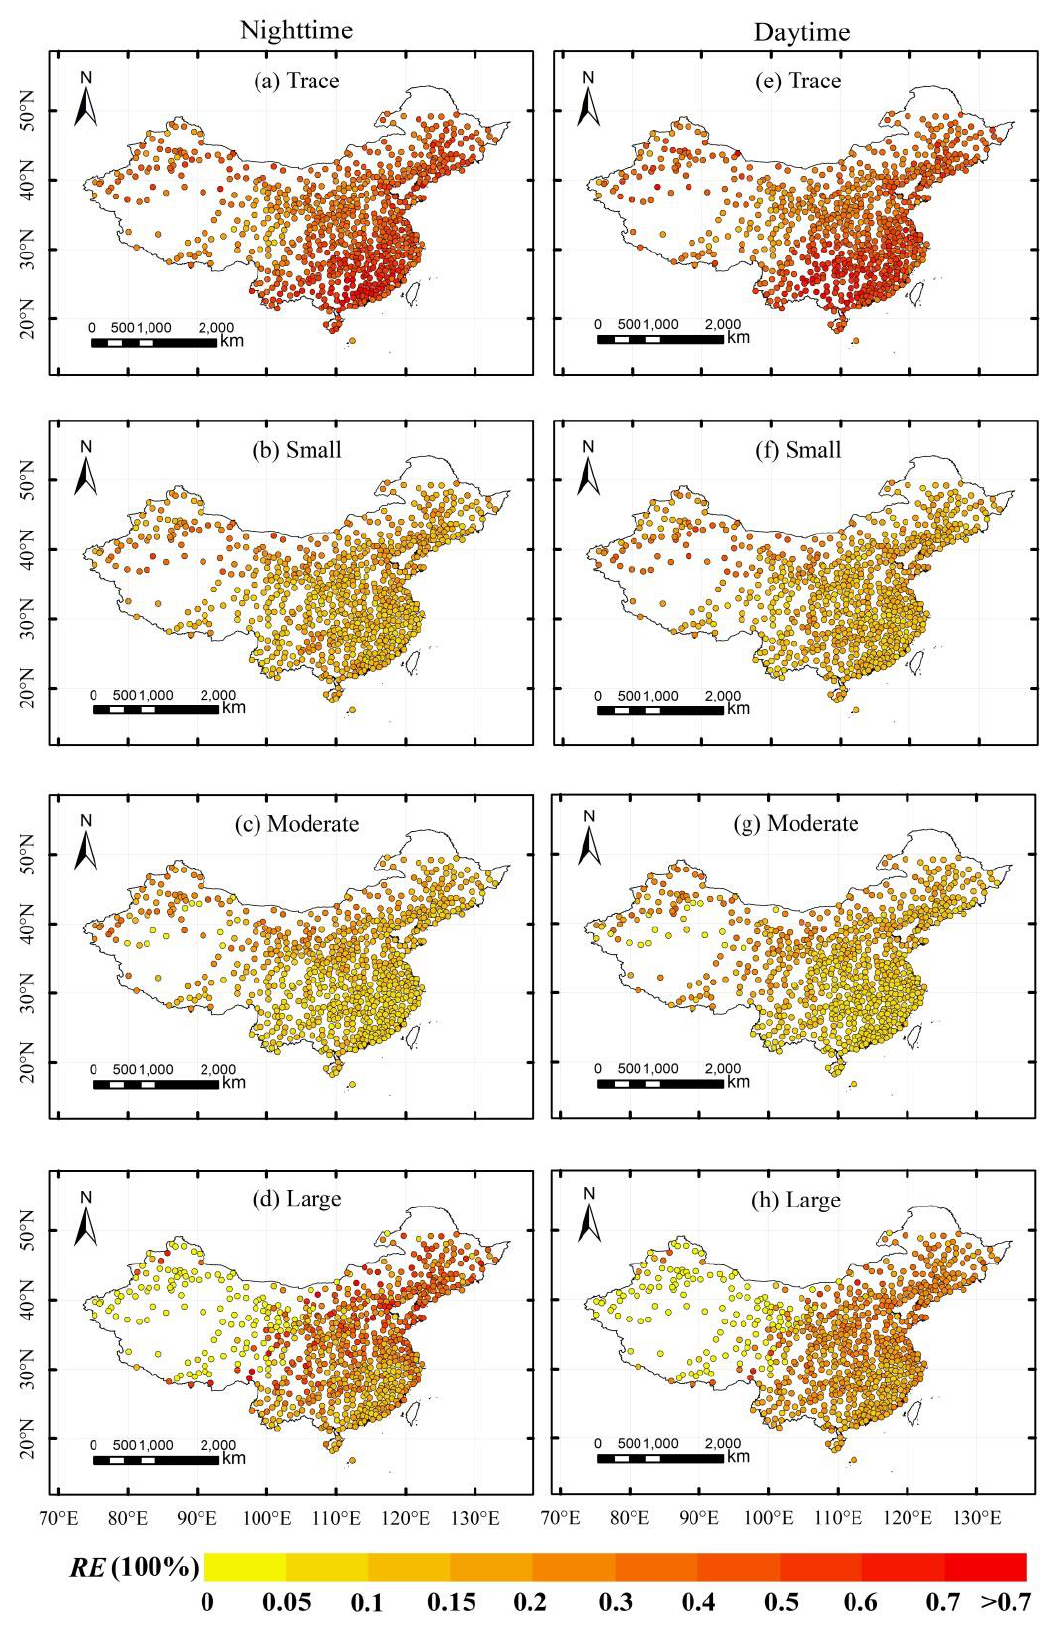
Figure 12. As in Figure 11, but for the intensity of precipitation.